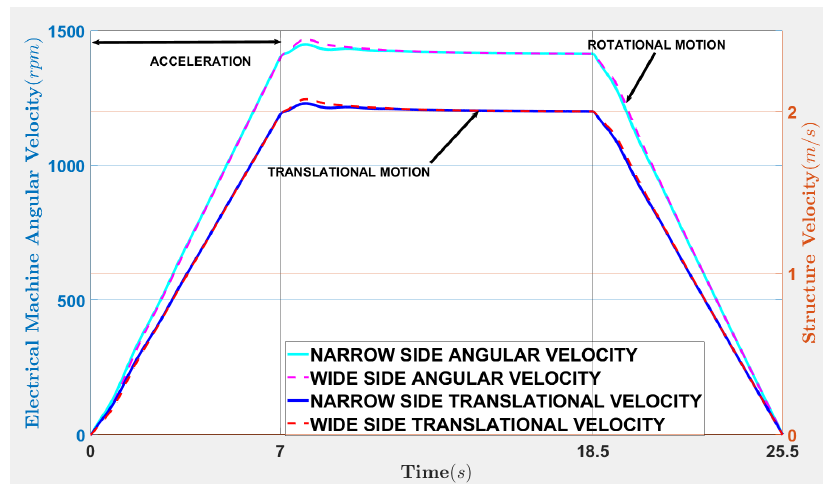
Figure 6. Electrical Machine Angular Velocity and Linear Velocity of the Structure.